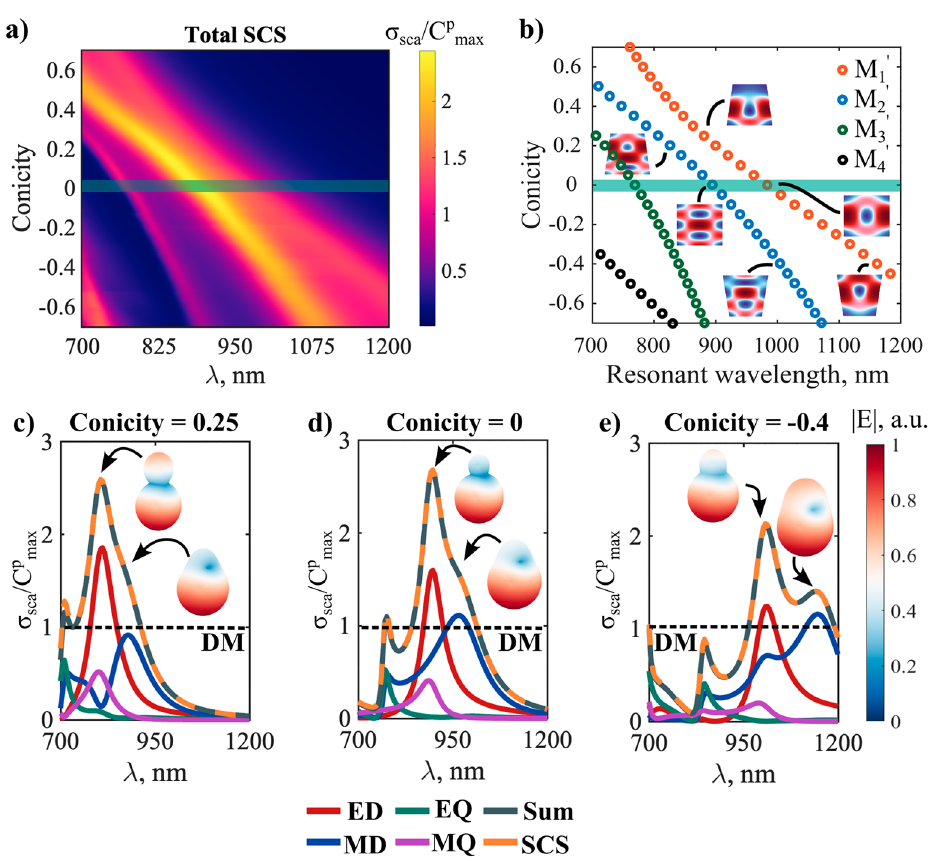
Figure 9. Evolution of the superscattering features as a function of conicity and wavelength. ( a ) Normalized total scattering cross-section of the perturbed cone under normal incidence plane wave excitation. ( b ) Resonant wavelengths of the QNMs (M 1 ’–M 4 ’) as a function of the conicity. Insets define modes inner fields at three selected conicities (red—more intense field, blue–less intense field). Cones height and bottom radius considered constant with values (500 nm) and (100 nm), respectively. The cones top radius was modified with constant step size in the range (30–170 nm), while the material is considered dispersionless ( n = 3.45) for calculations simplicity reasons. ( c – e ) Multipole decomposition of the normalized total scattering cross-section for the three selected conicities in ( a ). Scattering patterns at the peaks of the electric and magnetic dipoles resonances are inserted for each case. The dashed lines point to the dipolar channel scattering maxima in the case of spherical symmetric resonator (DM). Multipolar channels that contribute more than the DM are